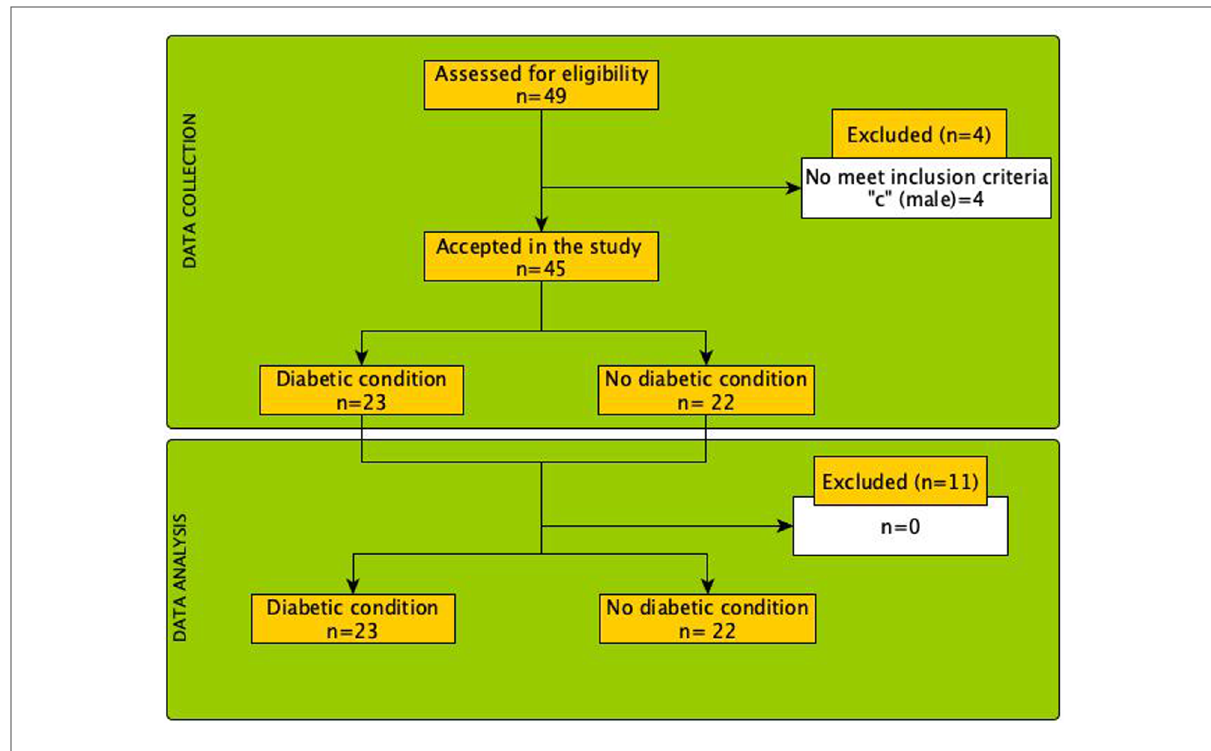
FIGURE 4 Flow diagram of the process of selection and analysis of the patients included in the present study.